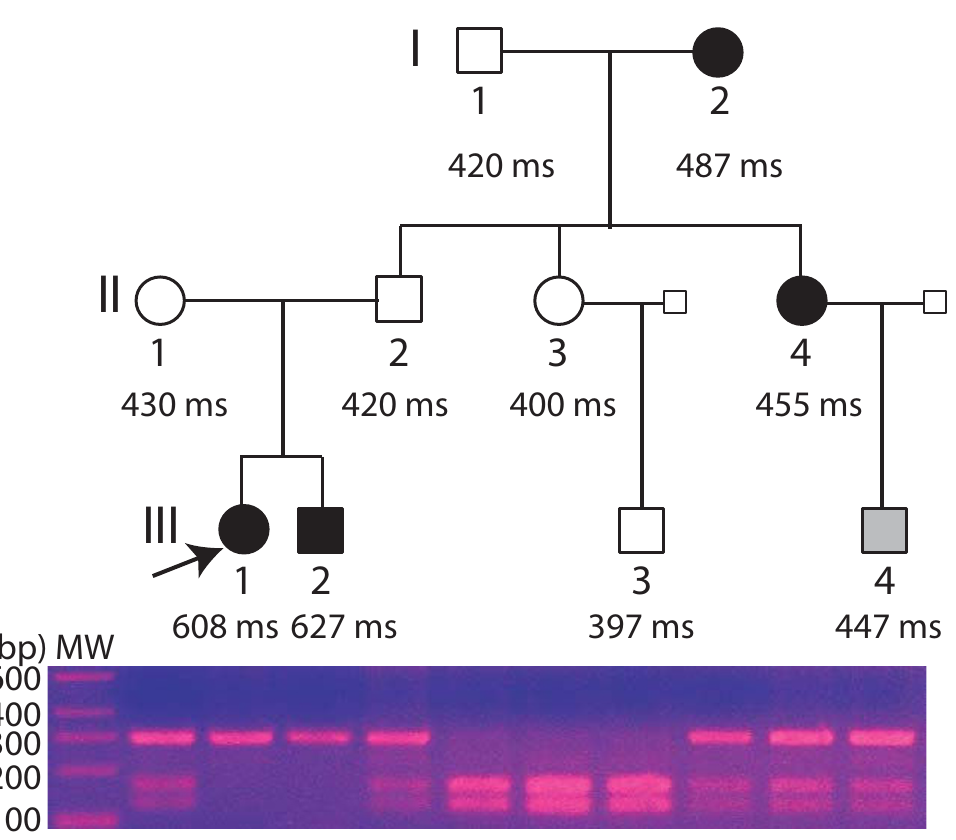
Figure 1 Pedigree structure of the Chinese family with JLNS and RWS. The results of RFLP analysis for mutation T322M are shown below each symbol. Affected male III:1 and females I:2 and III:2 are indicated with filled squares and circles; normal members are indicated with open symbols; individual III:4 with borderline QTc is shown with a gray symbol. QTc for family members is shown below each symbol as ms. The three-generation family is notable for the proband (III:1, indicated by an arrow) and her brother (III:2), who were affected with deafness and had a severely prolonged